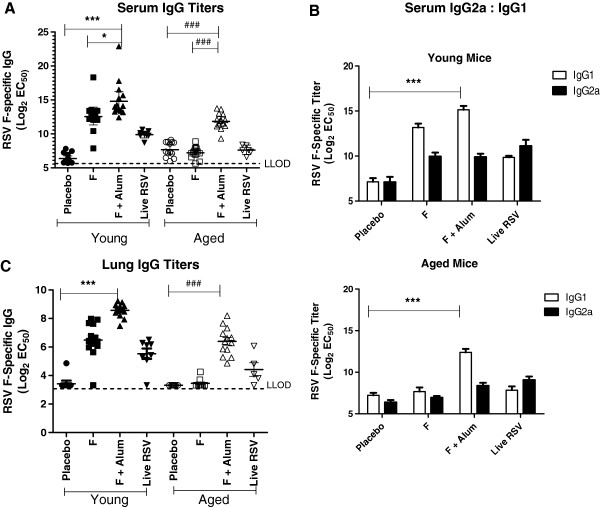
RSV F-specific serum and lung antibody titers in vaccinated young and aged BALB/c mice. Day 27 serum was examined by ELISA for (A) RSV F-binding IgG and (B) RSV F-binding IgG2a or IgG1 subtype antibodies using isotype-specific anti-mouse detection antibodies. (C) Lung homogenates 4 days post-challenge were examined for RSV F-binding IgG antibodies. The dotted line represents the lower limit of detection (LLOD= 1:50 dilution). ***, P < 0.0001 comparing F + alum to placebo in young mice (ANOVA). *, P < 0.05 comparing F + alum to F in young mice (ANOVA). ###, P < 0.0001 comparing F + alum to placebo or F in aged mice (ANOVA). Serology results were combined from two independent experiments.